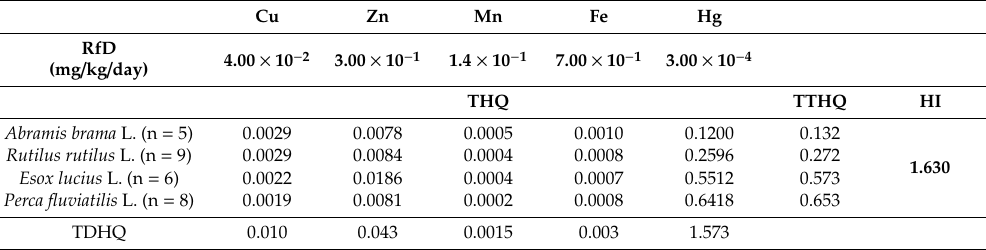
Table 5. The hazard quotient calculated for metals content in the muscle tissue of